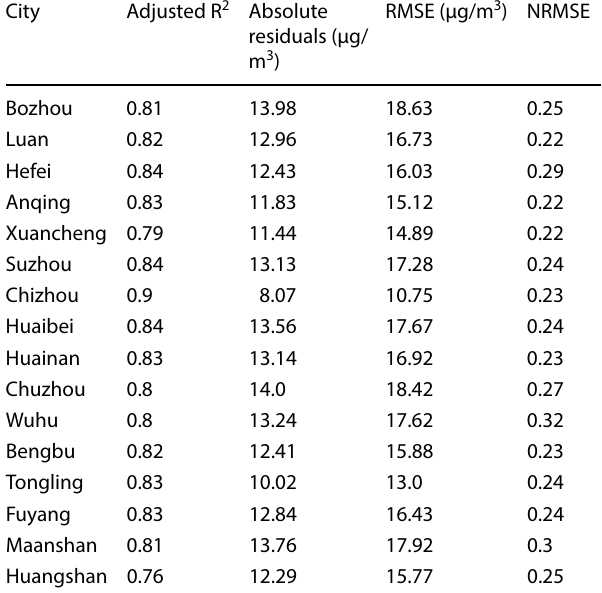
Table 1 Summary of the performance of GAMs in Anhui City